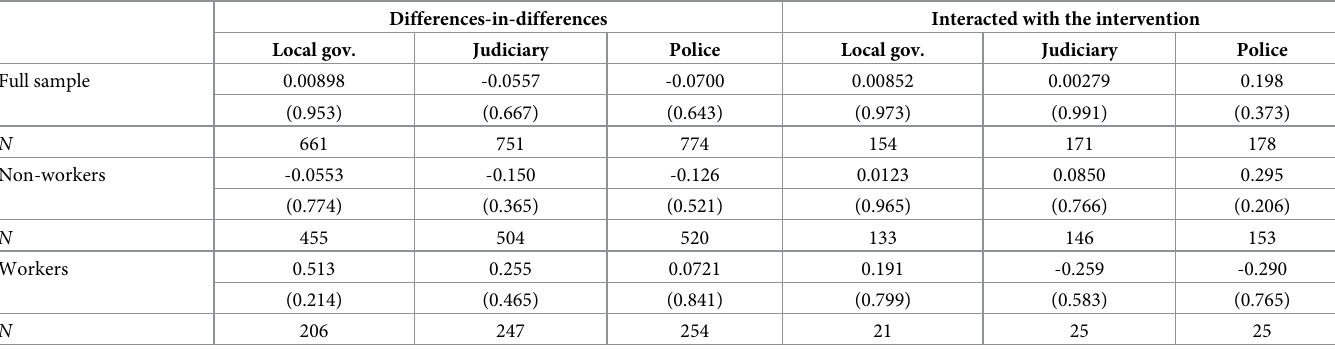
Table 7. Estimates of the effect on the evaluation of different